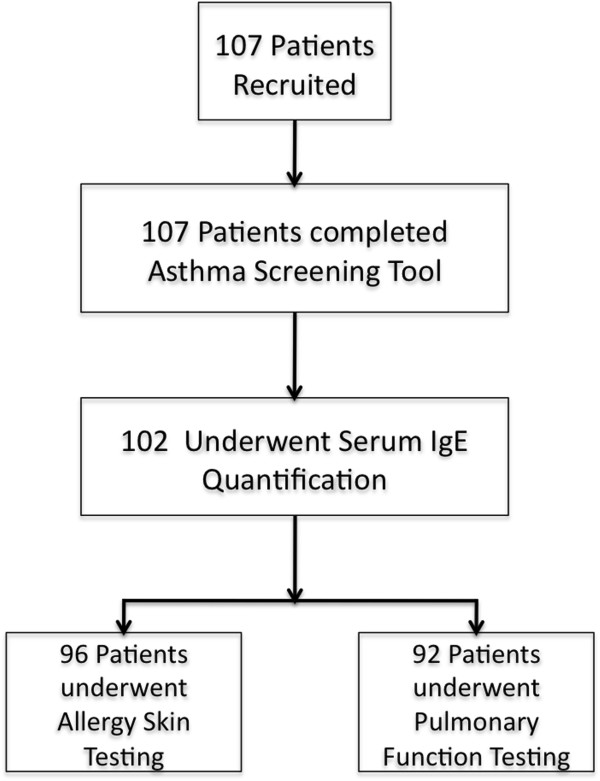
Patient recruitment and attrition.